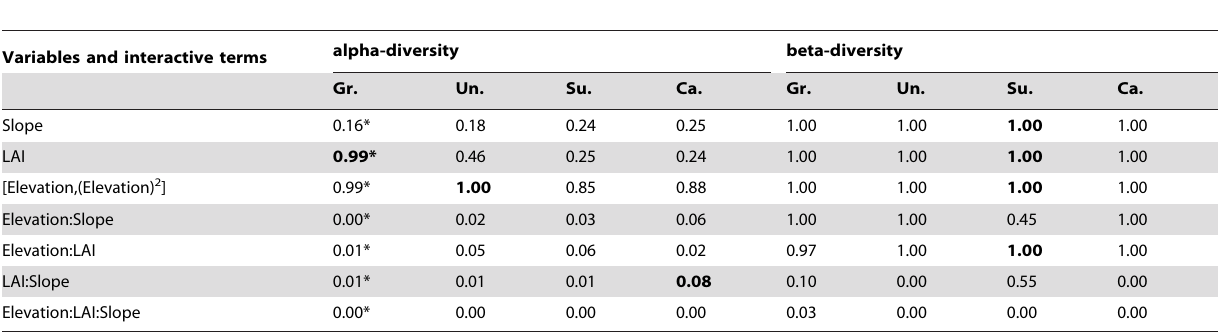
Table 1. Summary of the relative importance of factors in determining alpha- and beta-diversity (Fisher’s alpha) of vegetation along an elevational gradient on Mt Rinjani,